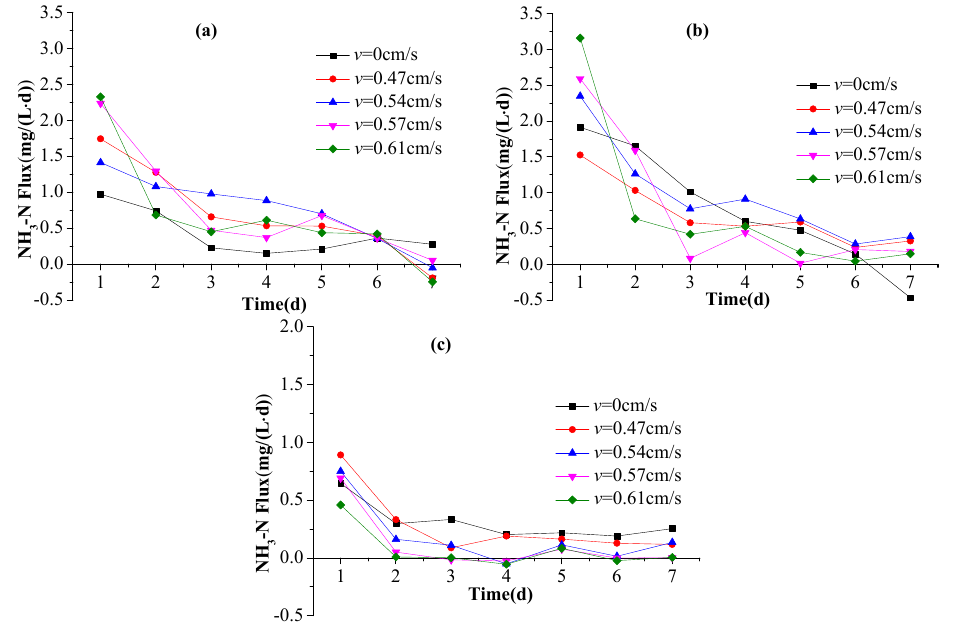
Figure 7. The release flux of NH 3 ‐ N during the course of the experiment measured at depths of: ( a ) 6 cm; ( b ) 3 cm; and ( c ) 1 cm within the sediments. Table 1. The regression equations for the NH 3 ‐ N release flux.